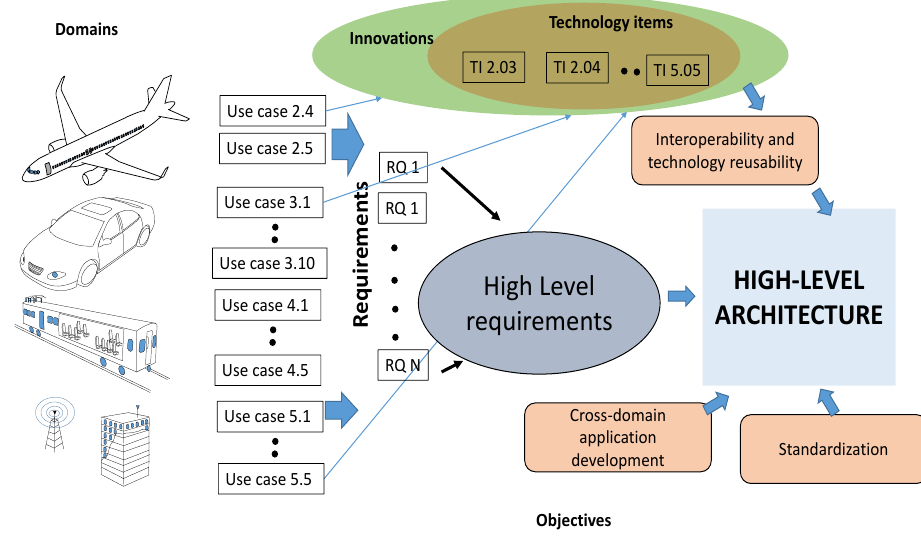
Figure 1. Design elements of the DEWI infrastructure and HLA. The DEWI HLA provides flexible, federated and standardized access to sensor read- ings and TIs of different industrial domains with distinct underlying transmission tech- nologies and data formats. This is one of the main issues in future systems of the IoT. The DEWI HLA also enables the use of actuators controlled by automated applications or by human clients using sensor and context information acquired by DEWI nodes. Therefore, our approach crossovers with the field of M2M communications. External developers will be able to create smart city and Big Data applications using the DEWI application program interfaces